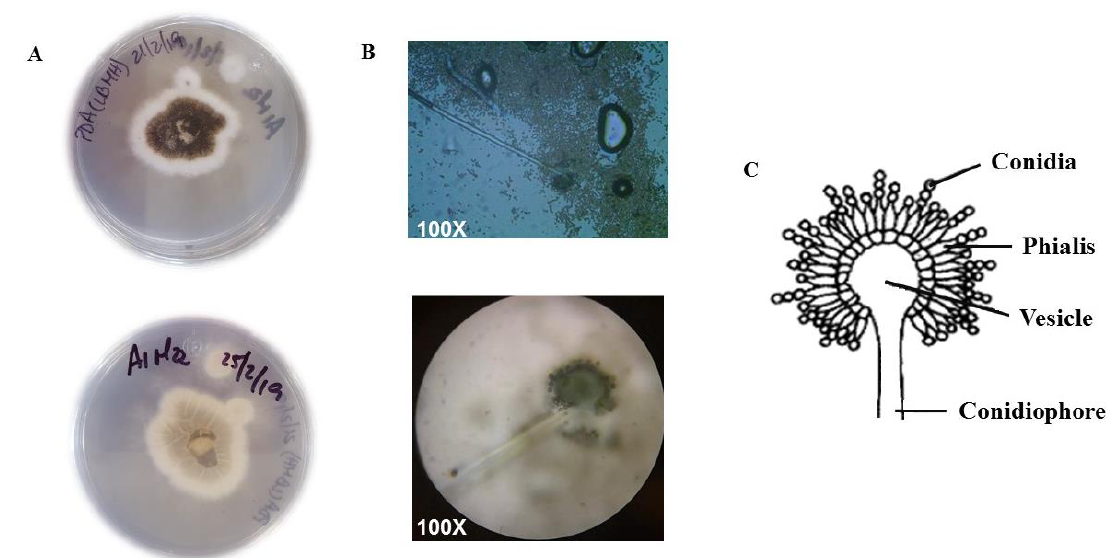
Figure 4. Macroscopic and microscopic appearance of strain C7. ( A ) PDA Petri dishes showing the mycelium from above (upper dish) and from below (lower dish). ( B ) Microscopic observation of the conidiophores and conidia of strain C7. ( C ) Drawing representing the asexual reproductive apparatus of Aspegillus species. Table 2. Closest neighbors for Aspergillus luchuensis strain C7 based on 28S, calmodulin and β - tubulin markers blast comparison. Only three representative hits are shown per marker.